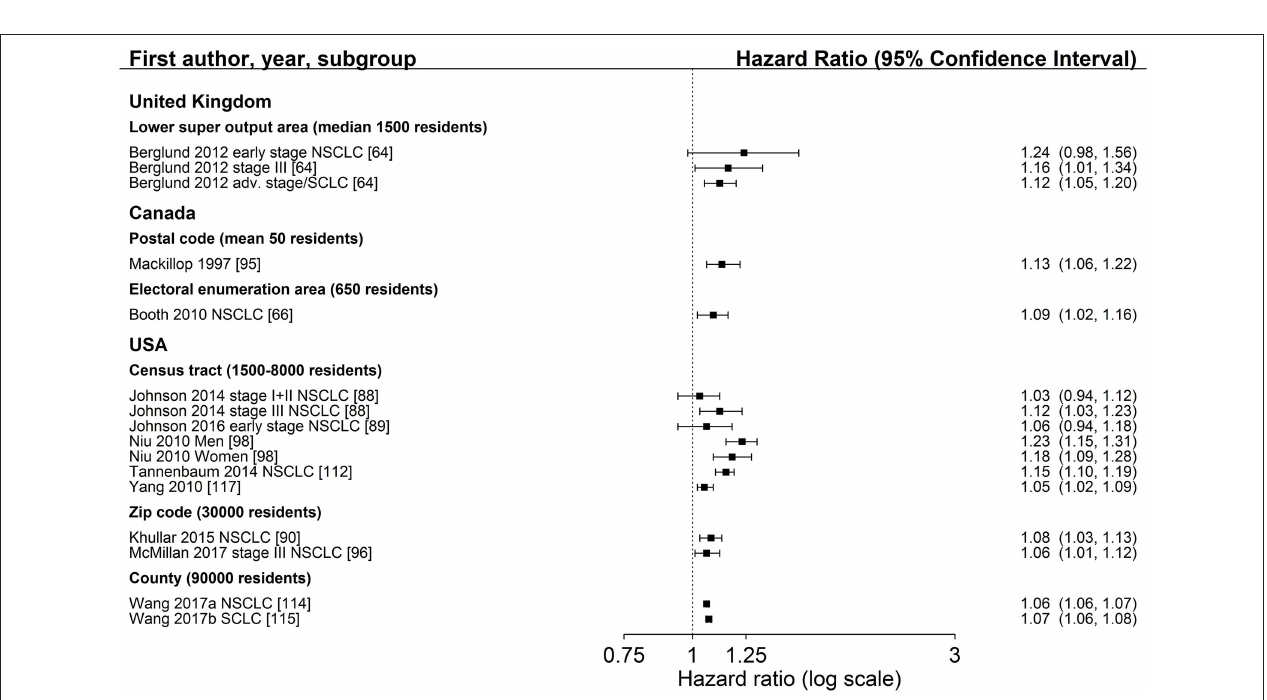
FIGURE 4 | Association of area-based income (reference: high income) and survival after lung cancer. Order: small to large area level. NSCLC, non-small cell lung cancer; SCLC, small cell lung cancer.